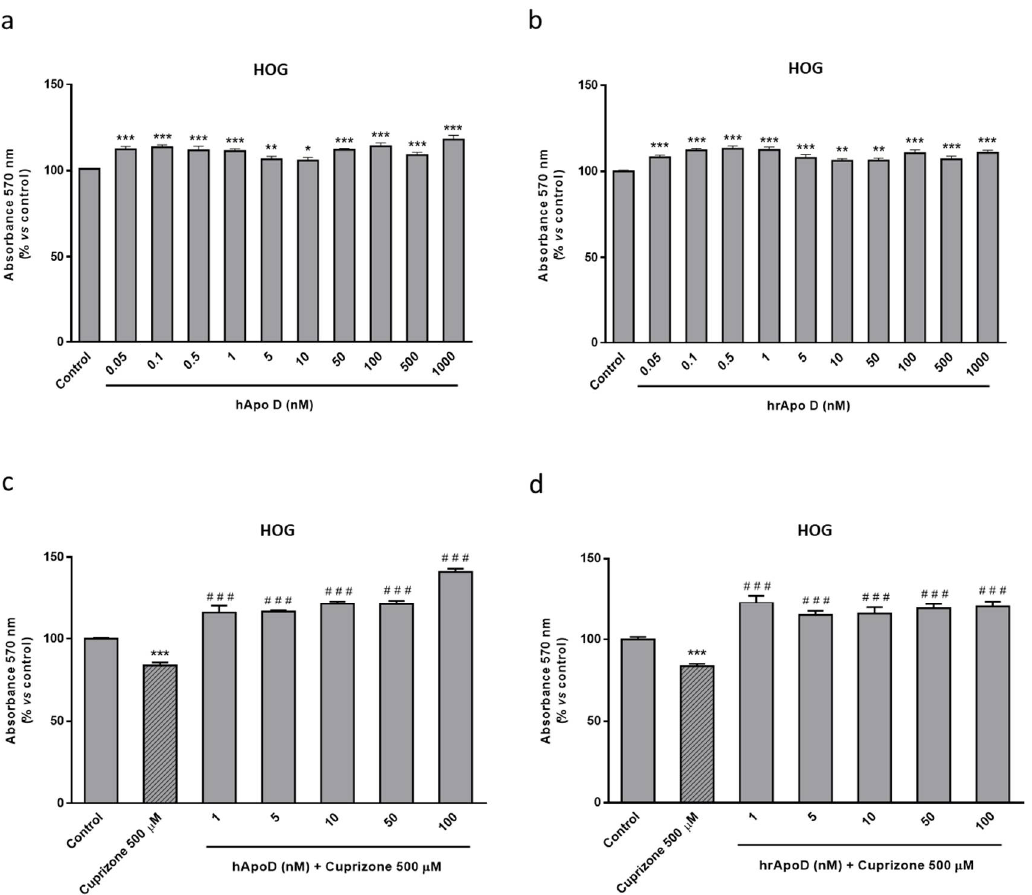
Figure 8. Top panel: MTT assays in HOG cells treated with increasing concentrations (0.05–1000 nM) of hApo D ( a ) or of hrApo D during 24 h ( b ). Bottom panel: MTT assays in HOG cells treated with increasing concentrations (1–100 nM) of hApo D ( c ) or of hrApo D ( d ) for 24 h followed by 24 h with 500 µM of CPZ. Cell damage is represented as the percentage of viability versus control. Data are the mean ± SEM of five independent experiments. Significant differences were analyzed by a one-way ANOVA followed by post-hoc Tukey’s test. * p < 0.05, ** p < 0.01, *** p < 0.001 compared with control; ### p < 0.001 compared with CPZ treatment.